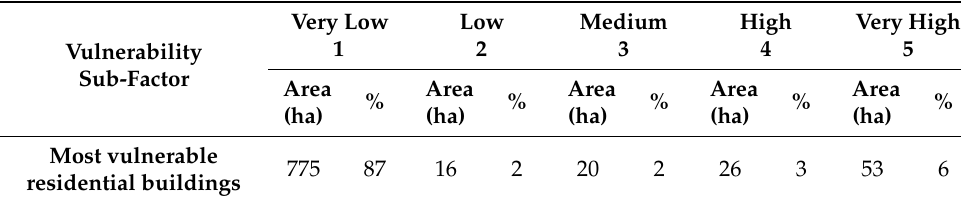
Table 30. Areas and percentages of the study area classified as each class of the vulnerability subfactor, residential buildings (most vulnerable residential